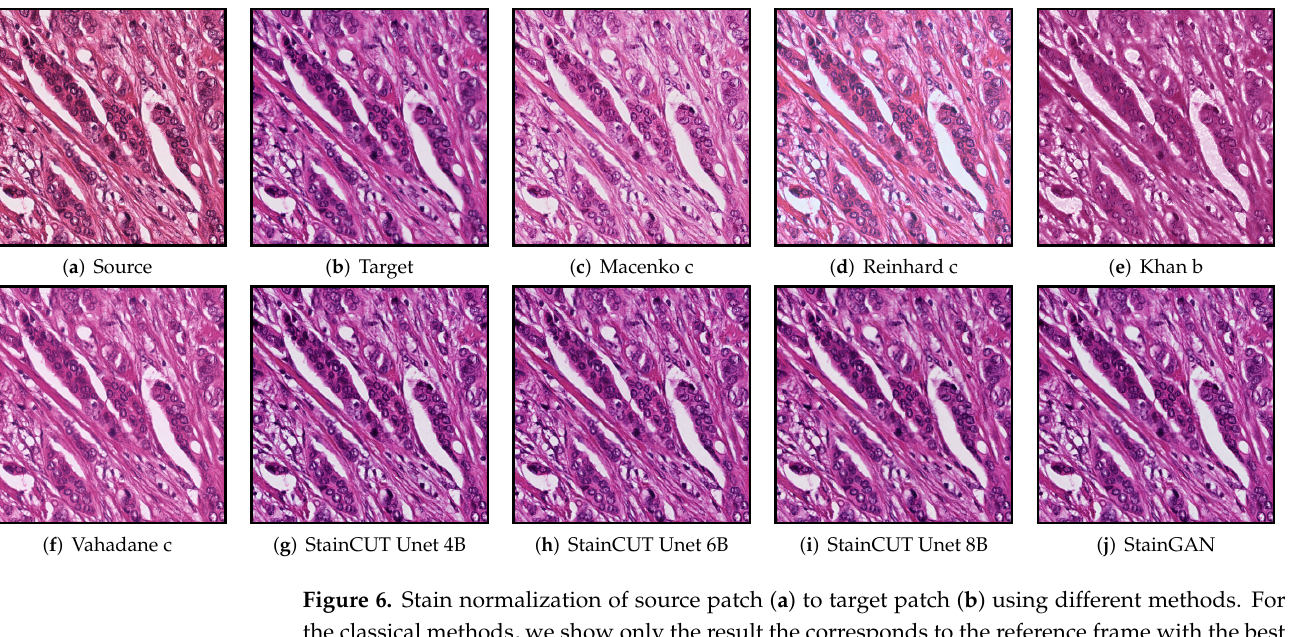
Figure 4. Boxplots from the evaluation of the SSIM metric for all compared methods on the MITOS-ATYPIA dataset. Each box is drawn from the first to the third quartile. The horizontal line represents the median value and the triangle represents the mean. The whiskers indicate the minimum and maximum value of the distribution.